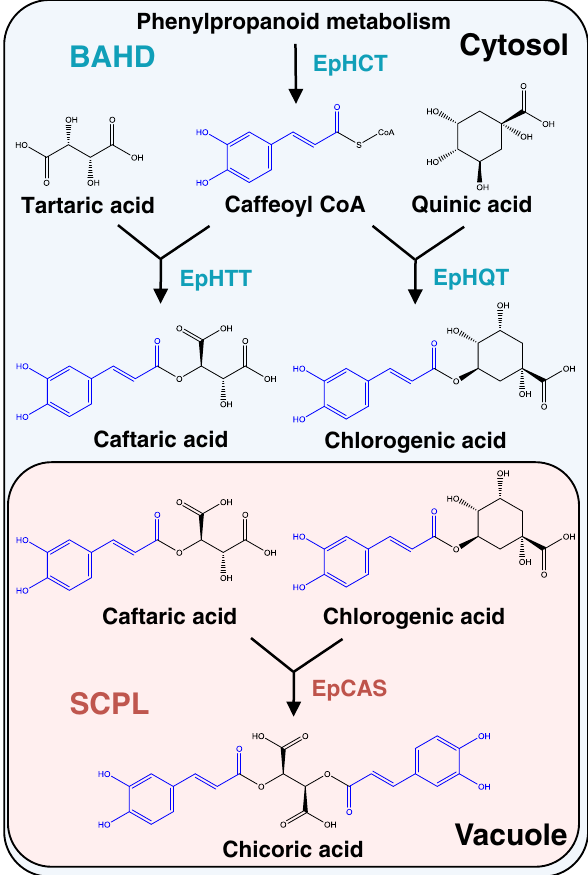
Fig. 7 Schematic representation of the proposed chicoric acid biosynthetic pathway in purple cone fl ower. Two types of acyltransferases distributed in distinct subcellular compartments are involved in the biosynthesis of chicoric acid. In the cytosol, the BAHDs including EpHTT and EpHQT use caffeoyl CoA from phenylpropanoid metabolism as an acyl donor to synthesize caftaric acid and chlorogenic acid, respectively. Both products are then transported into the vacuole. EpCAS, a specialized SCPL acyltransferase, uses chlorogenic acid as its acyl donor instead of 1- O - caffeoyl- β -D-glucose and transfers the caffeoyl group to caftaric acid to generate chicoric